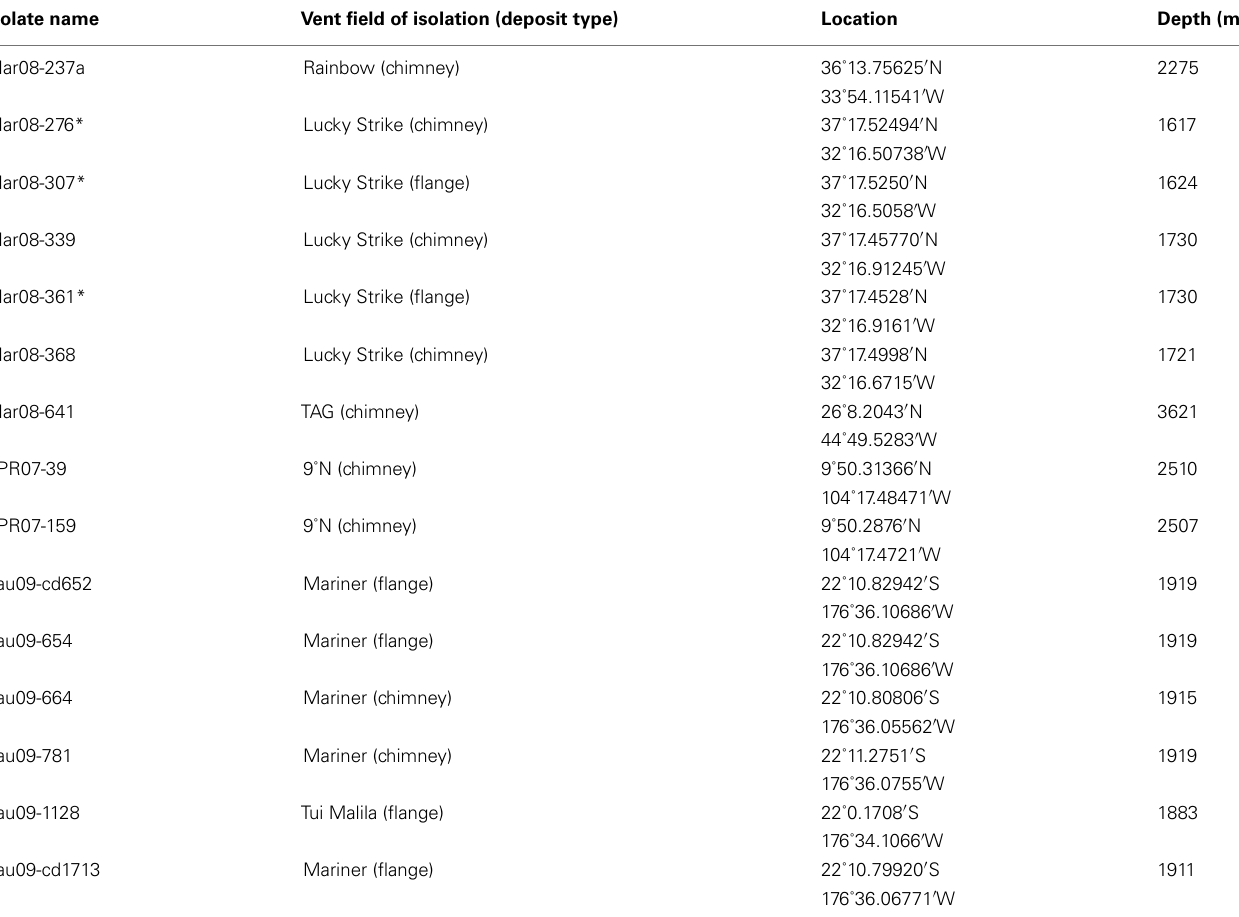
TableA3 | Hydrothermal vent deposits from which new DHVE2 isolates were